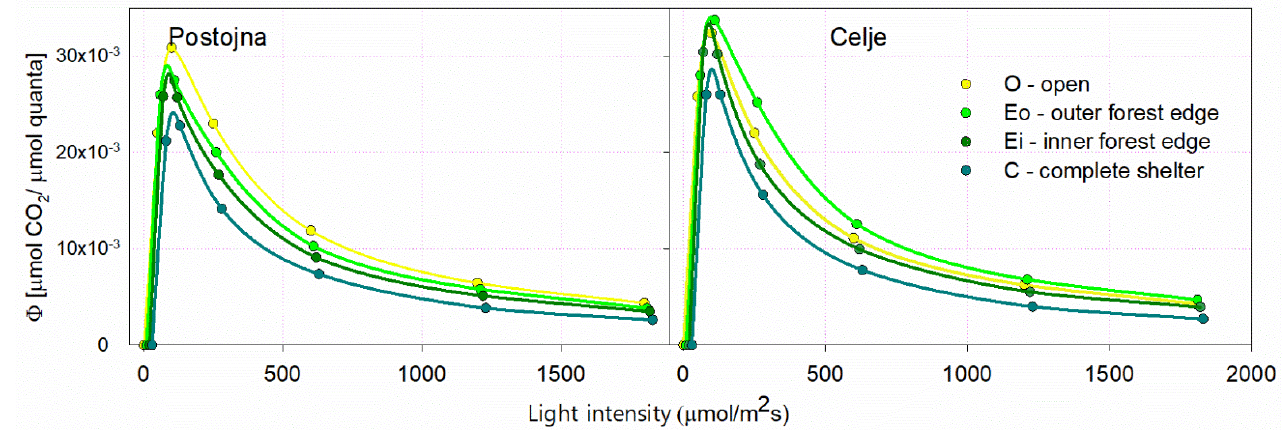
Figure 7. Light use efficiency ( Φ ) for light categories in Postojna and Celje.